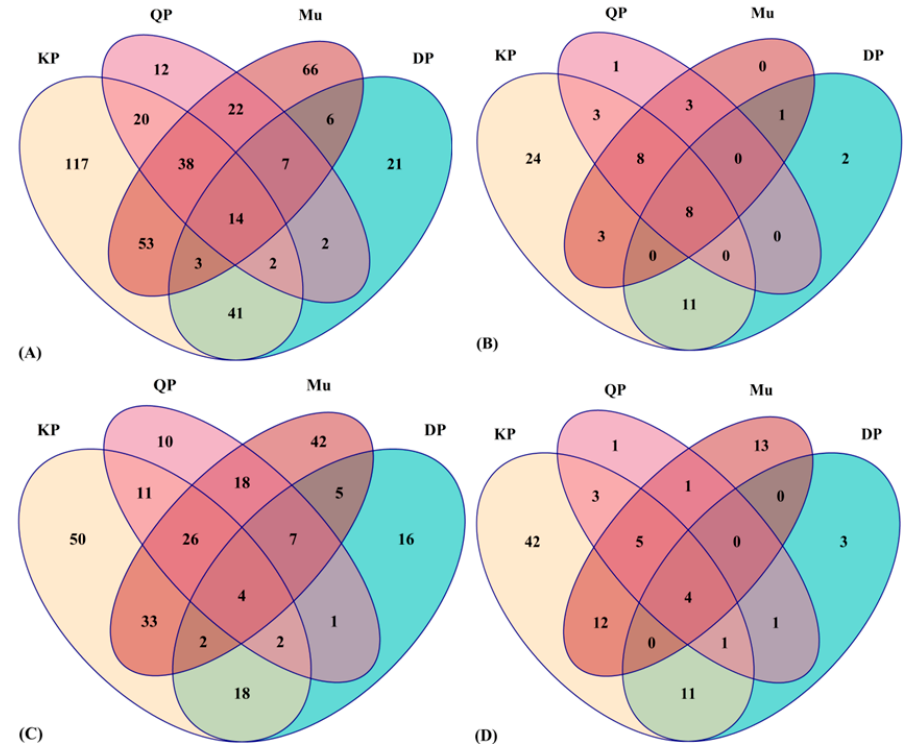
Figure 3. Venn diagram distribution of the total number of phytochemicals ( A ), the total number of phenolic acids ( B ), the total number of flavonoids ( C ), and the total number of other polyphenols ( D ) in Muntries (Mu), Kakadu plum (KP), Davidson plum (DP) and Quandong peach (QP).